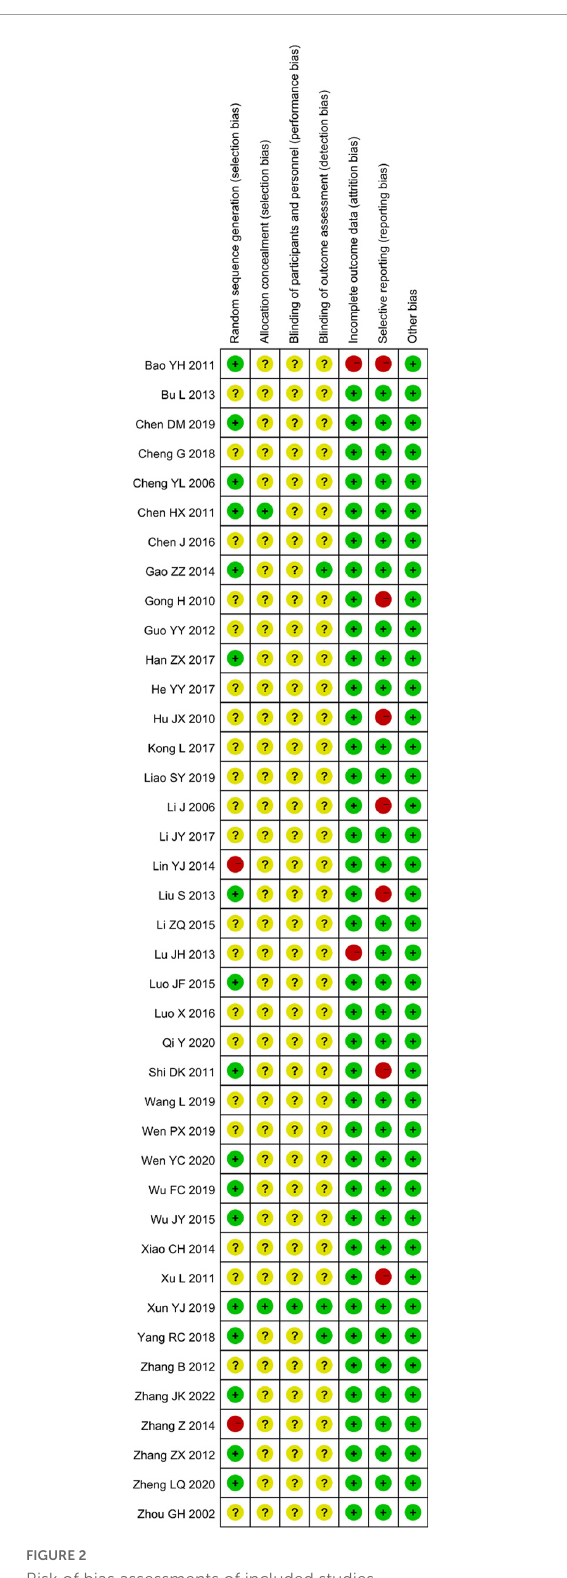
FIGURE2 Risk of bias assessments of included